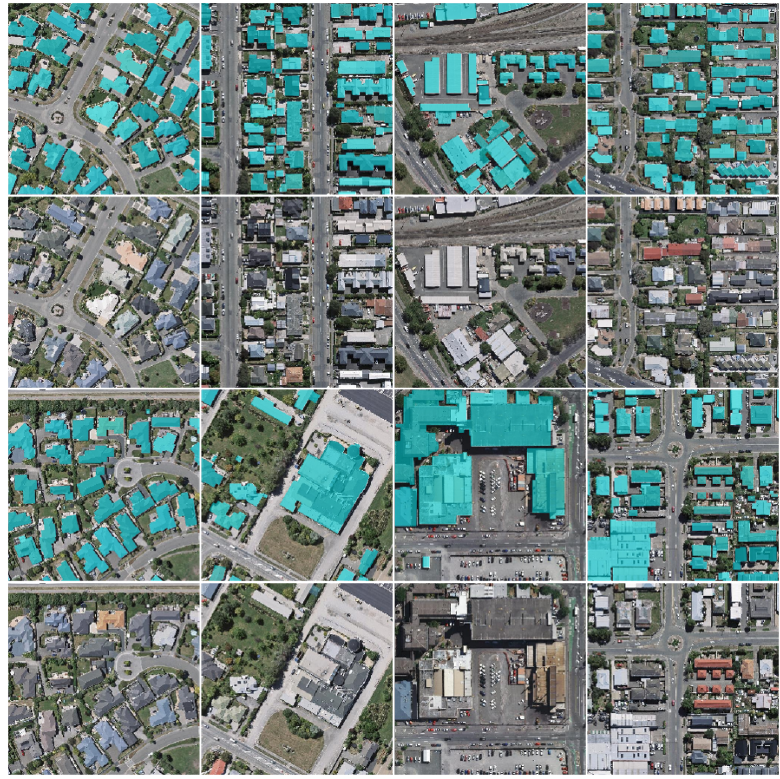
Figure 5. Samples of the WHU aerial imagery dataset. The ground truth of the buildings is in